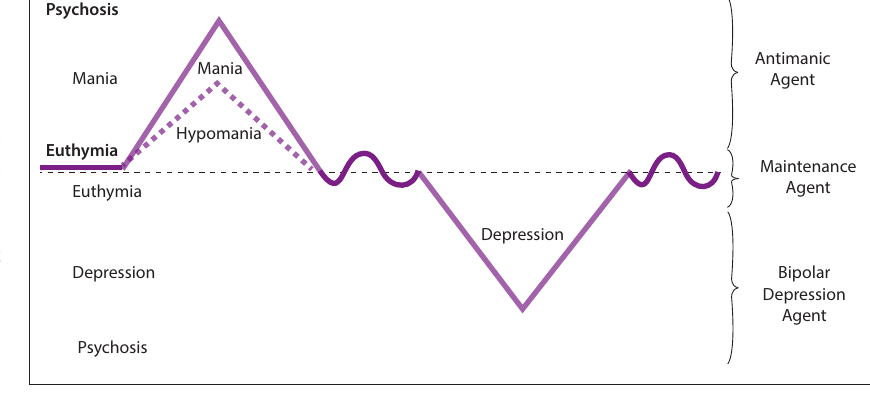
Fig. 1. Phases of bipolar illness with matching treatment terminology.